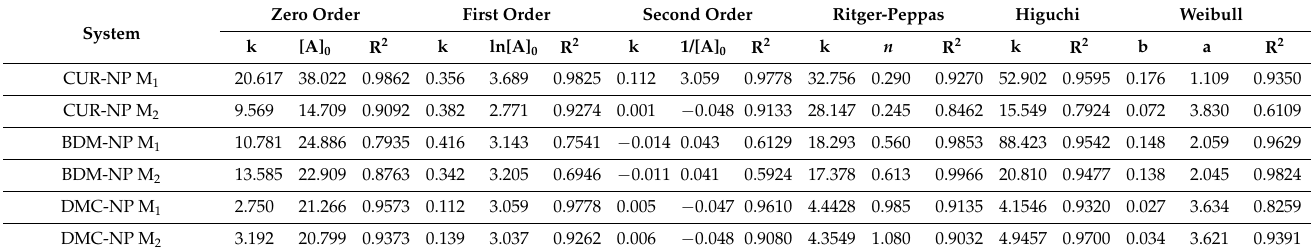
Table 2. Results of fitting the curcuminoids release kinetics experimental data to the kinetic equation proposed by six different kinetic